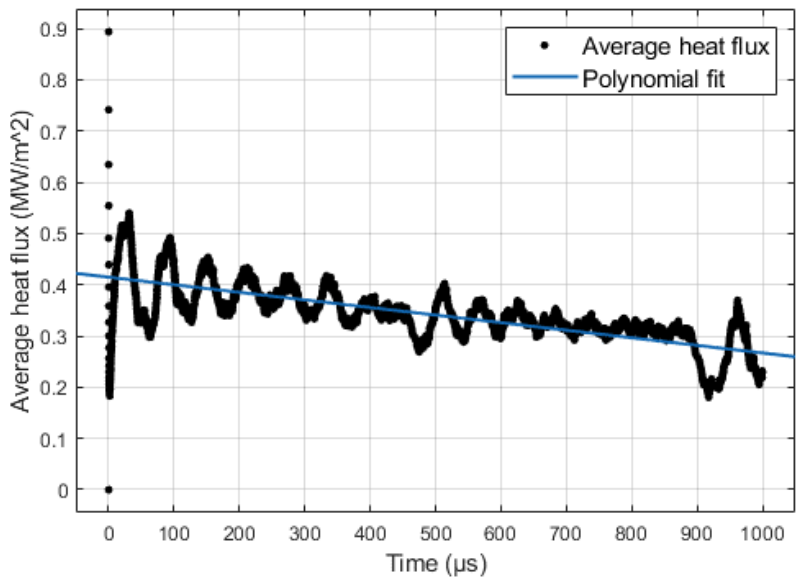
Figure 9. Surface-averaged heat flux via simulation of single-droplet impingement at a velocity of 1 m/s onto a stationary wall.